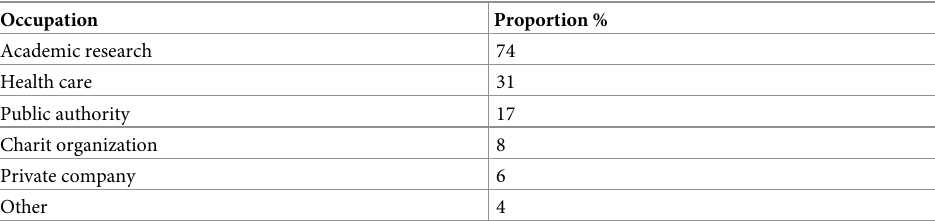
Table 1. Characteristics of medical expert informants’